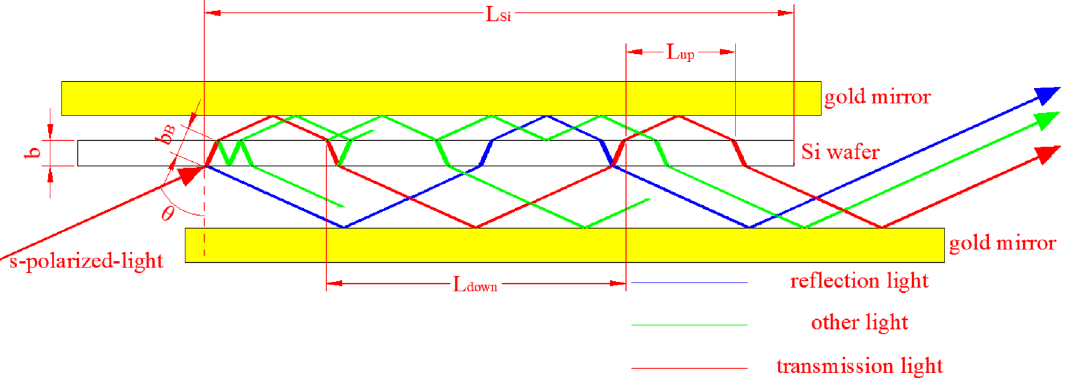
Figure 4. Optical path diagram of s-polarized light in the MTR setup. Only a few transmission times (N = 4) are illustrated for simplicity and clarity. However, in reality, N can reach a maximum of 12. b B corresponds to the optical path length of light passing through the silicon wafer once at the Brewster incidence angle, cm. L up and L down are defined as the periodic horizontal lengths from a spot on the upper and lower faces of silicon where a single ray impinges to the next spot where the ray impinges on the upper and lower surfaces of the silicon wafer again after returning from a gold mirror, respectively. L Si is the effective length of the silicon wafer. The image was created using AutoCAD 2014 (simplified Chinese), http://win.xmjfg